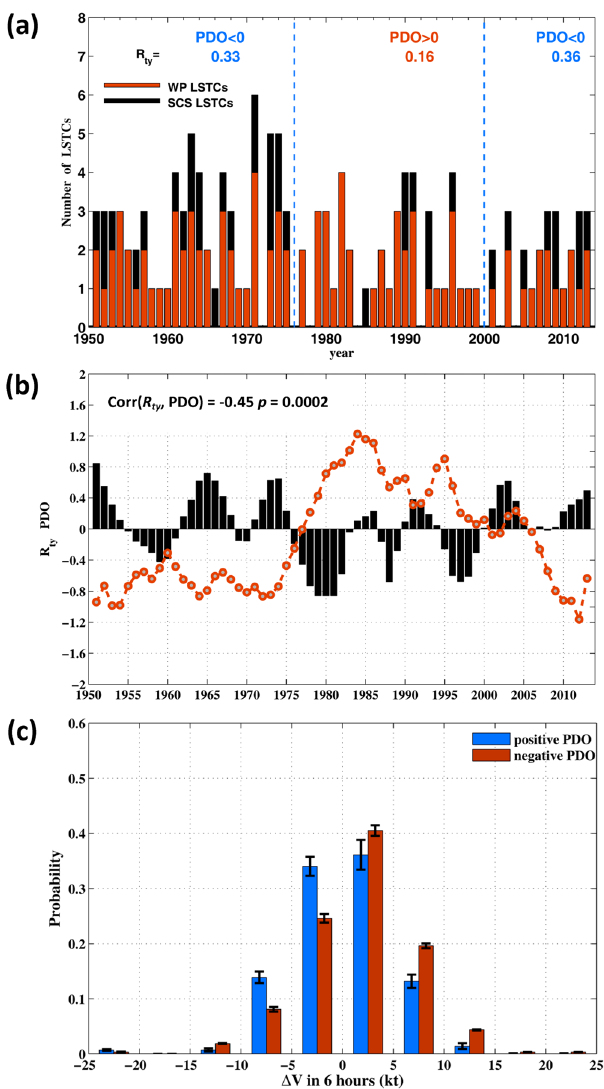
Figure 2. ( a ) Numbers of WP-(red bars) and SCS-(black bars) intensifying LSTC’s based on the IBTrACS data from 1951–2013; top display shows values of R ty averaged over periods of positive and negative PDOs indicated by vertical dashed lines. ( b ) R ty anomaly normalized by its standard deviation σ (s.d. = 0.27) (black bars) and the PDO index (red dashed line), 6-year running mean applied to both; a tapered smoothing is applied to end points; top-left display shows the correlation between R ty and PDO and the corresponding p -value. ( c ) Probability distribution of 6-hourly intensity changes ( Δ V) of LSTCs in SCS sampled by positive and negative PDOs. Units are knots [1 knot (kt) = 0.51 m s − 1 ] per 6 hours. Data are in bins of 5-kt resolution. Error bars show ±σ from the mean probability for that